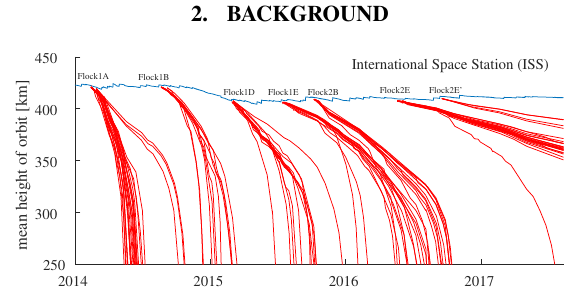
Figure 1. Orbital decay of the ISS in blue and different generations of Planet cubesats (called Doves) deployed from it. For every Dove the orbit altitude